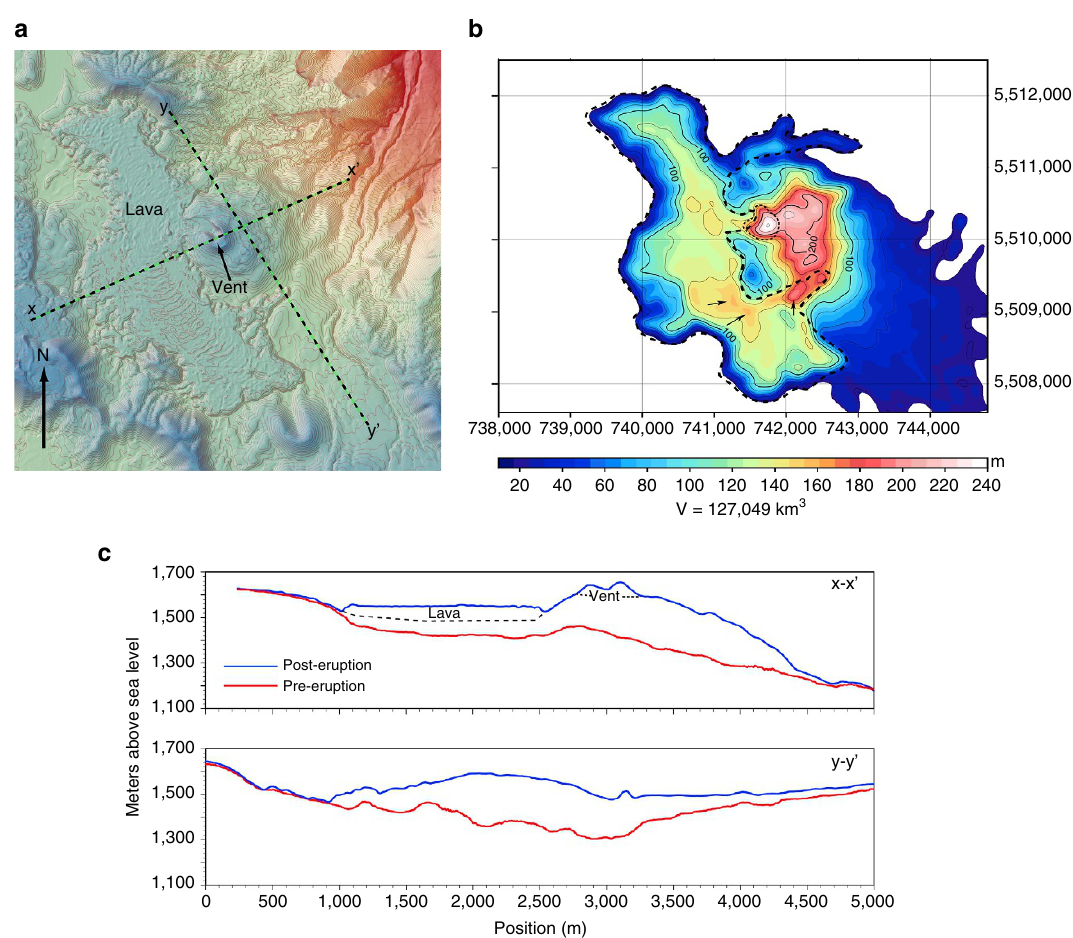
Figure 3 | Net surficial and volumetric changes from laccolith emplacement. ( a ) Post-eruptive DTM of Cordo´n Caulle (March 2014), and ( b ) surface elevation difference map constructed by subtracting the pre- from post-eruption DTMs. The series of colours and contours indicate uplift (m) due to intrusion and lava emplacement. Bold- and thin-dashed lines demarcate the lava flow and tephra cone bounds, respectively. Several areas within the lava flow correspond to anomalously large elevation differences (for example, indicated by orange colour and arrows) that reflect the combination of deformation and lava deposition. ( c ) topographic profile comparisons illustrating the extent and amount of uplift along lines x-x’ and y-y’. Contour lines are 10m apart in a and the elevations (m) along profiles are given in c on the y -axis. Deformation is concentrated in the eastern portion of the eruption area, however significant uplift ( 4 50m) is also prevalent beneath the lava flow (arrows in frame b ), whose expected base is shown by the dashed black line in the upper frame c